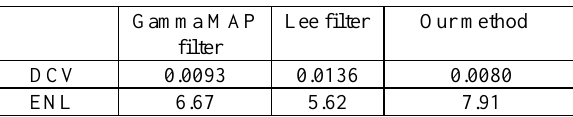
Table 2. Comparison of quantitative measures